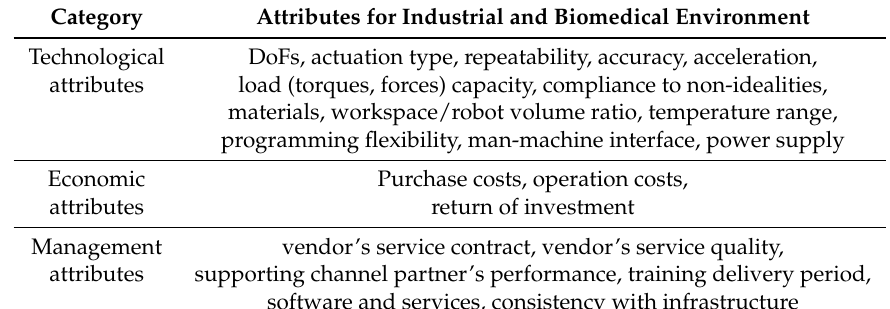
Table 3. Set of possible attributes of each category for the analyzed task in both the industrial and biomedical